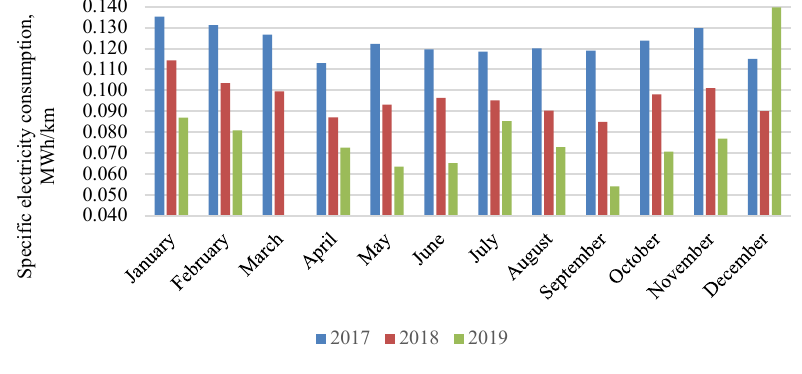
Fig. 2. Specific electricity consumption over three years